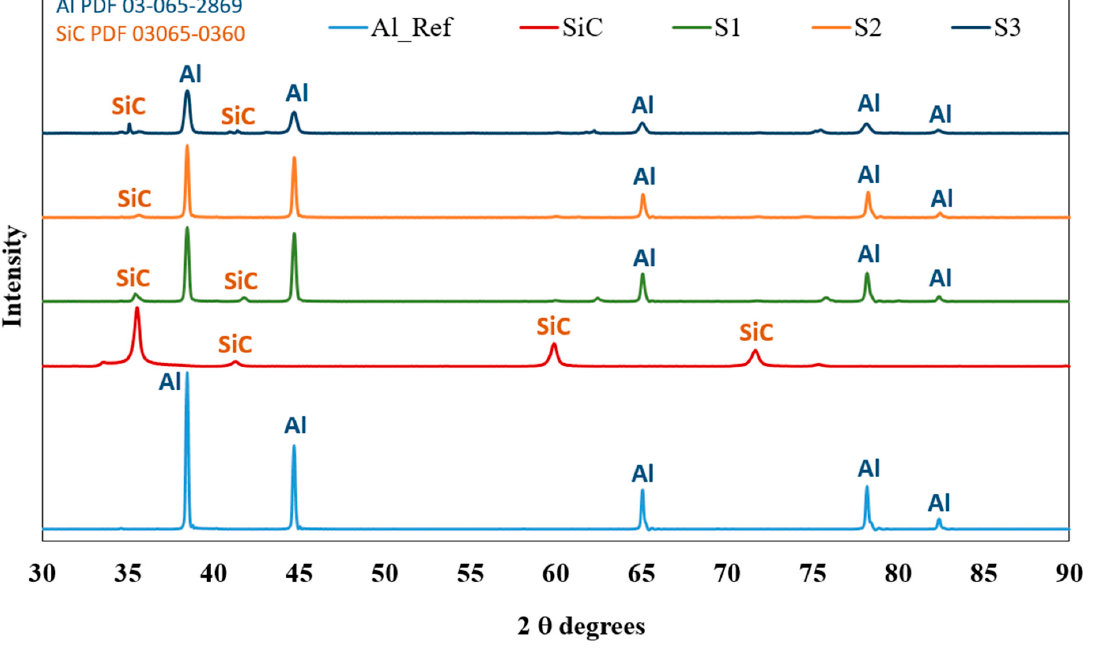
Figure 5. XRD pattern for Al/SiC bulk composites.